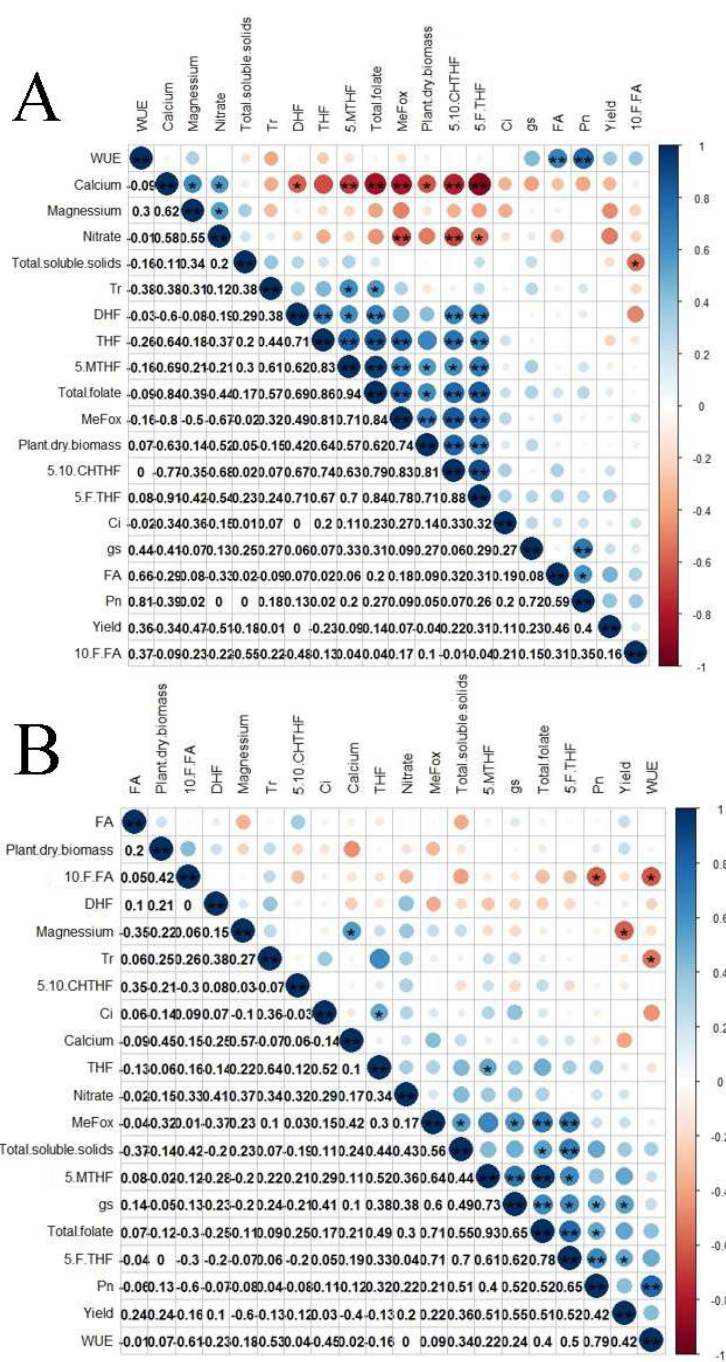
Figure 1. Correlogram based on Pearson’s correlation analysis between the folate derivatives and mineral contents of fruits of ( A ) ‘Xin Xian La 8 F1’cultivar — V43 and ( B ) ‘La Gao F1’ cultivar — V6. Correlation coefficients on the lower and left side of the correlogram; ‘*’ and ’**’ indicate significance of p value at 5% and 1% probability levels, respectively. Tr: transpiration rate; Ci: intercellular CO 2 ;